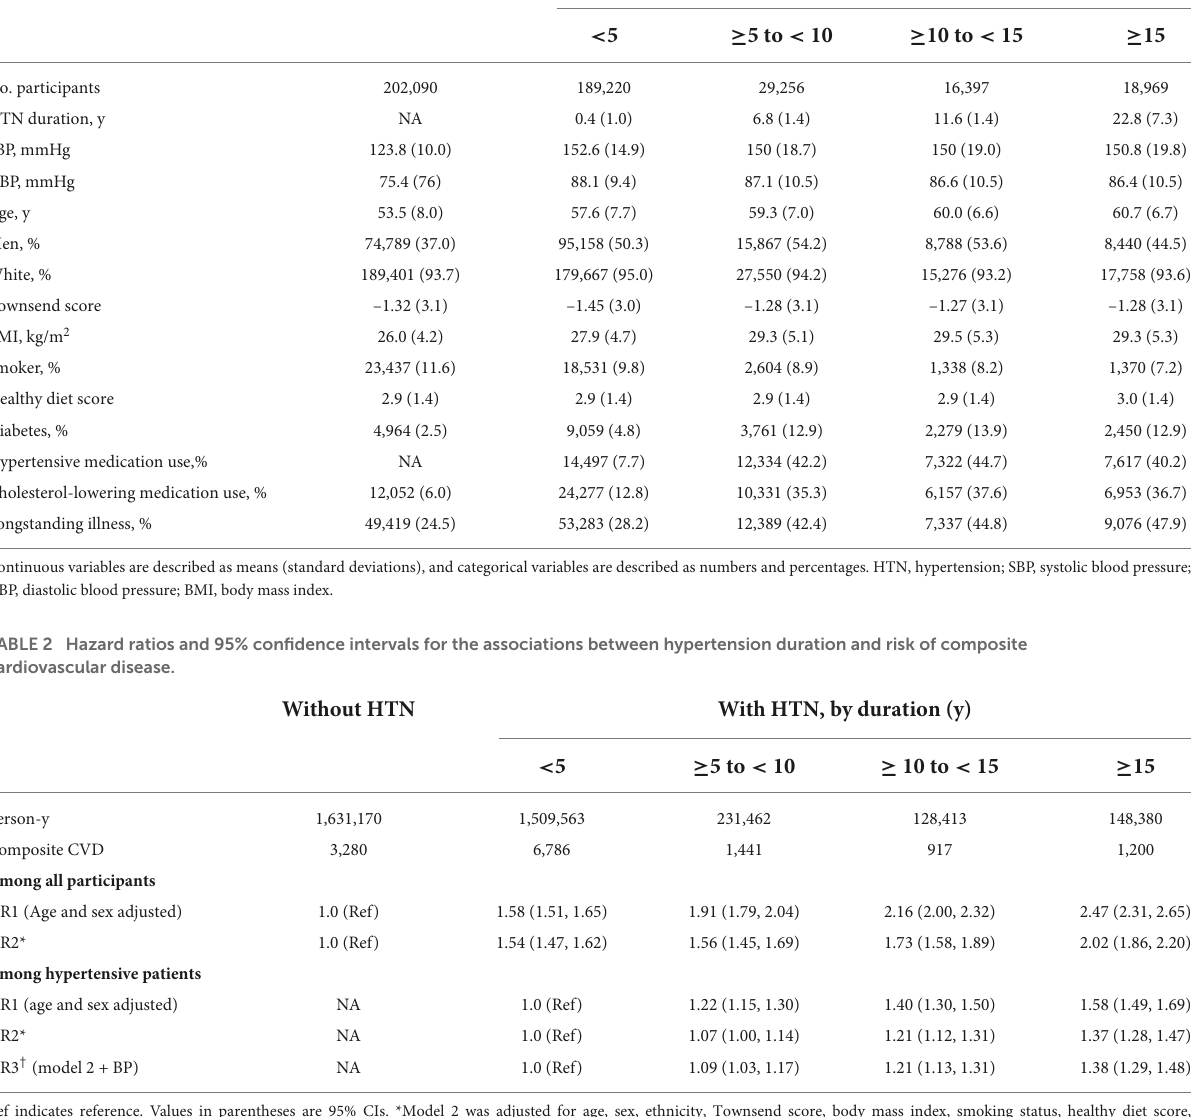
TABLE 1 Baseline characteristics of the included participants by hypertension status and hypertension duration. Without HTN With HTN, by duration (y) < 5 ≥ 5 to < 10